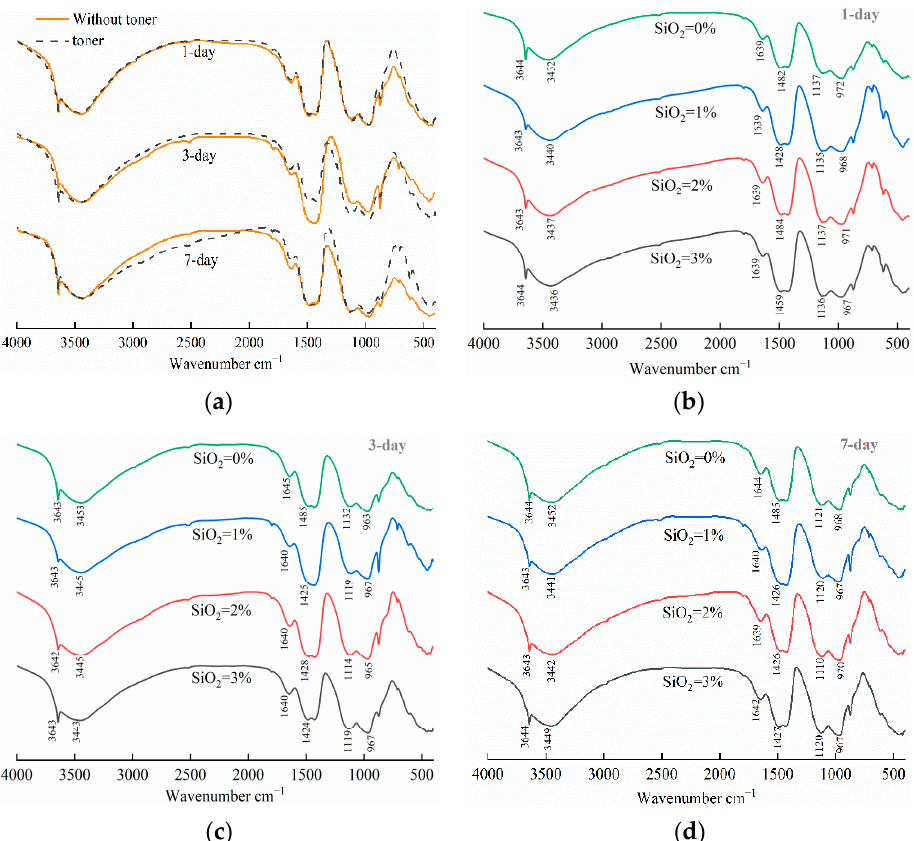
Figure 8. FTIR spectrums. ( a ) Cement grouting materials without the N ‐ S, ( b ) CRTS at 1 ‐ day, ( c ) CRTS at 3 ‐ day, ( d ) and CRTS at 7 ‐ day.